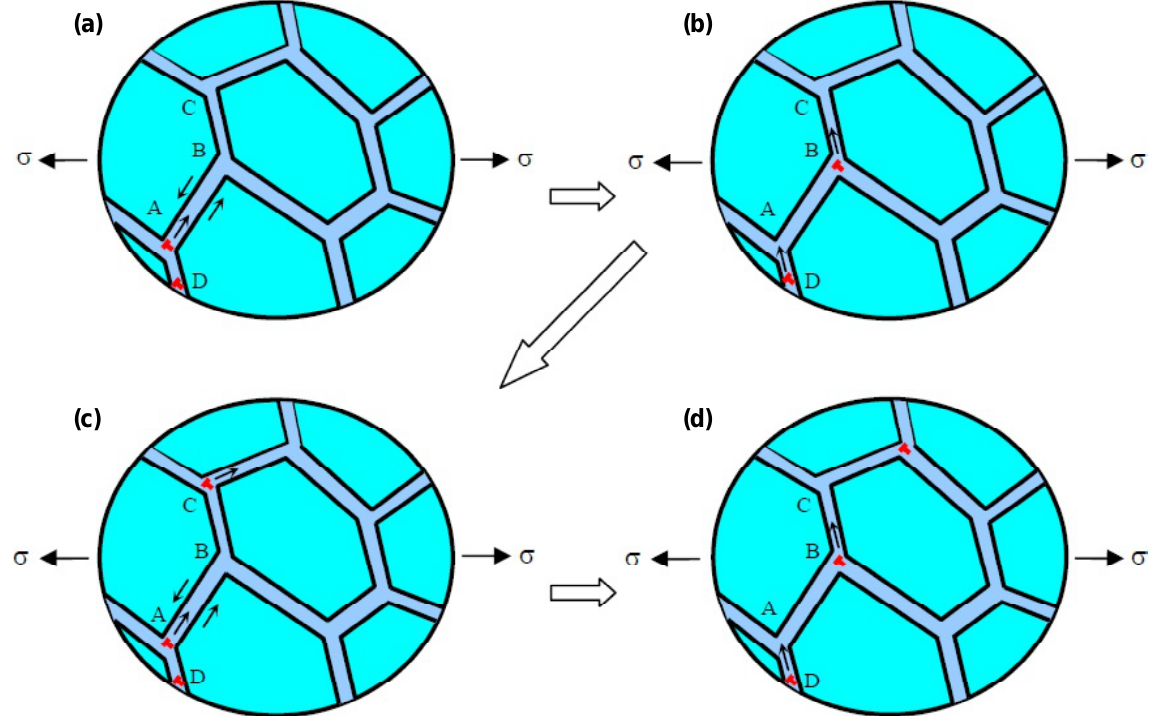
Fig. 5. Grain boundary sliding accommodated by grain boundary dislocation climb in a deformed metallic solid. (a) A fragment of a nanocrystalline or ultrafine-grained metallic solid under a uniform tensile stress  . The slip of a grain boundary dislocation along grain boundary AB results in sliding over this boundary. (b) Grain boundary dislocation climbs from triple junction B over neighboring grain boundary BC. At the same time, new grain boundary dislocation comes to grain boundary AD. (c) Grain boundary dislocation at grain boundary AD reaches triple junction A and starts to slip along grain boundary AB, providing further sliding over this grain boundary. (d) Climb of grain boundary dislocations over grain boundaries BC and AD